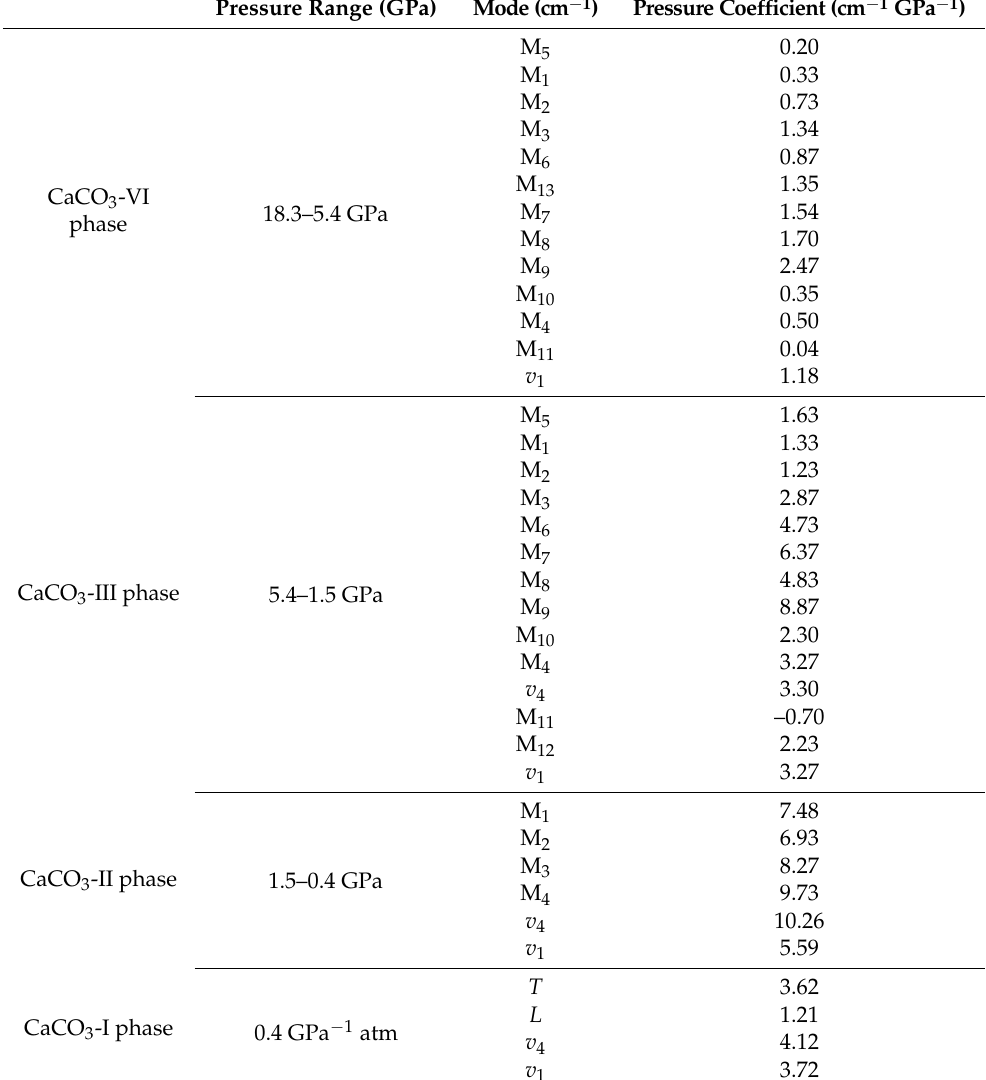
Table 2. Pressure coefficients of the Raman modes of CaCO 3 -I, CaCO 3 -II, CaCO 3 -III, and CaCO 3 -VI phases upon decompression within the pressure range from 18.3 GPa − 1 atm at room